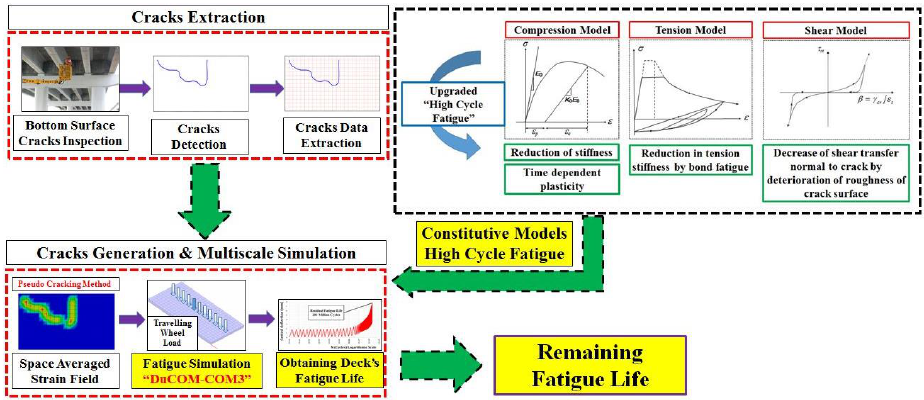
Figure 1. Data assimilation technology.